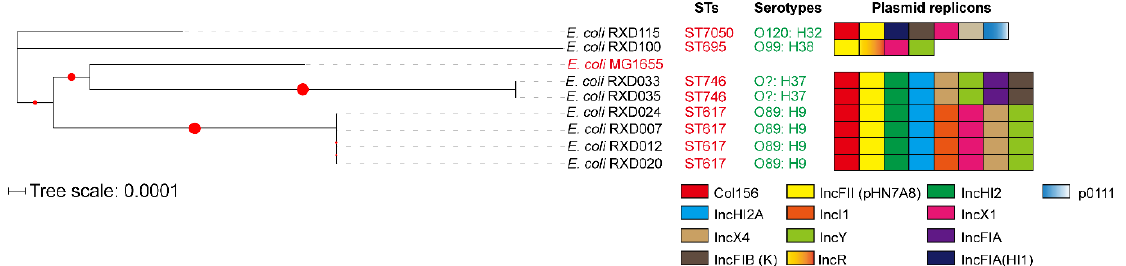
Figure 4 . Phylogenetic analysis of the eight carbapenem-resistant and colistin-resistant E. coli isolates. Sequence types, O-serotypes, H-serotypes, and plasmid replicons are also shown. The evolutionary history was inferred by using the Maximum Likelihood method and Tamura–Nei model. The tree with the highest log likelihood ( − 13321.25) is shown. The percentage of trees in which the associated taxa clustered together is shown next to the branches. Initial tree(s) for the heuristic search were obtained automatically by applying Neighbor-Join and BioNJ algorithms to a matrix of pairwise distances estimated using the Maximum Composite Likelihood (MCL) approach, and then selecting the topology with superior log likelihood value. The tree is drawn to scale, with branch lengths measured in the number of substitutions per site. This analysis involved nine nucleotide sequences. There was a total of 9093 positions in the final dataset. Evolutionary analyses were conducted by using MEGA X. The circles denote bootstrap values within the range of